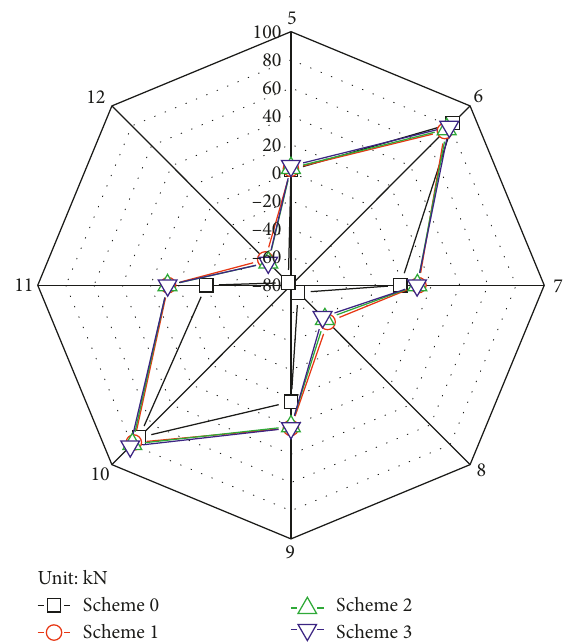
Figure 19: Additional normal forces of the tunnel structure after the building